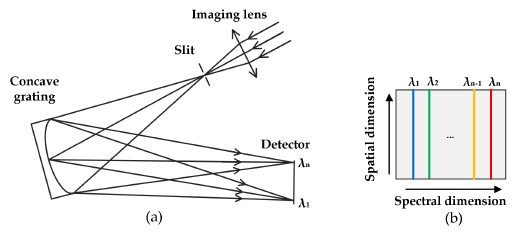
Figure 1. Schematic of a typical concave grating spectrometer. ( a ) Structure of the spectrometer. It consists of a fore lens, a slit, a concave grating and a detector. ( b ) Slit images on the focal plane. The horizontal axis represents the spectral dimension, whereas the vertical axis represents the spatial